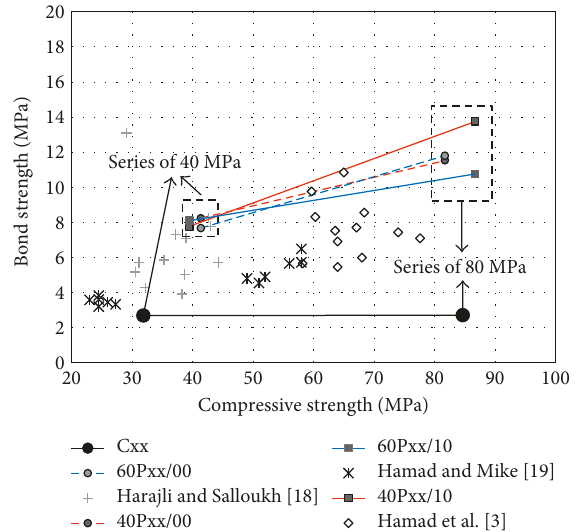
Figure 8: Bond strength of lap splice reinforcement [3, 18,